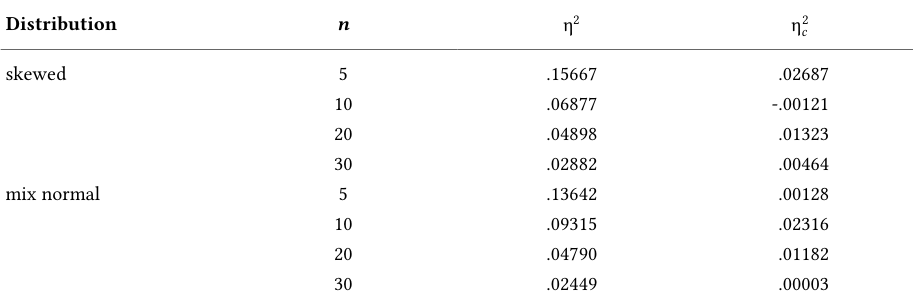
Bias Estimates for η 2 and η c2 Under Non-Normal Distributions Distribution n η 2 η c2 skewed 5